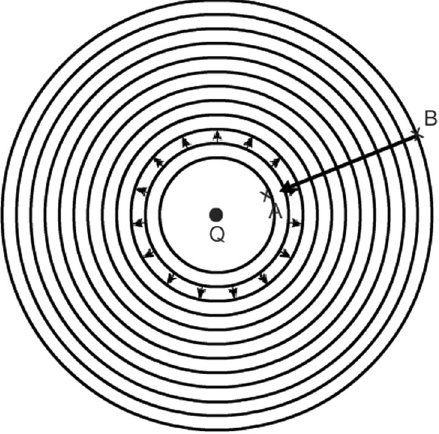
FIG. 8. Example representation of electric potential designed in control for the extra information design. The black arrow moves from point B to point A . Radiating black arrows representing the local electric field between two different rings appear briefly when the tip of the moving arrow touches the corresponding ring.